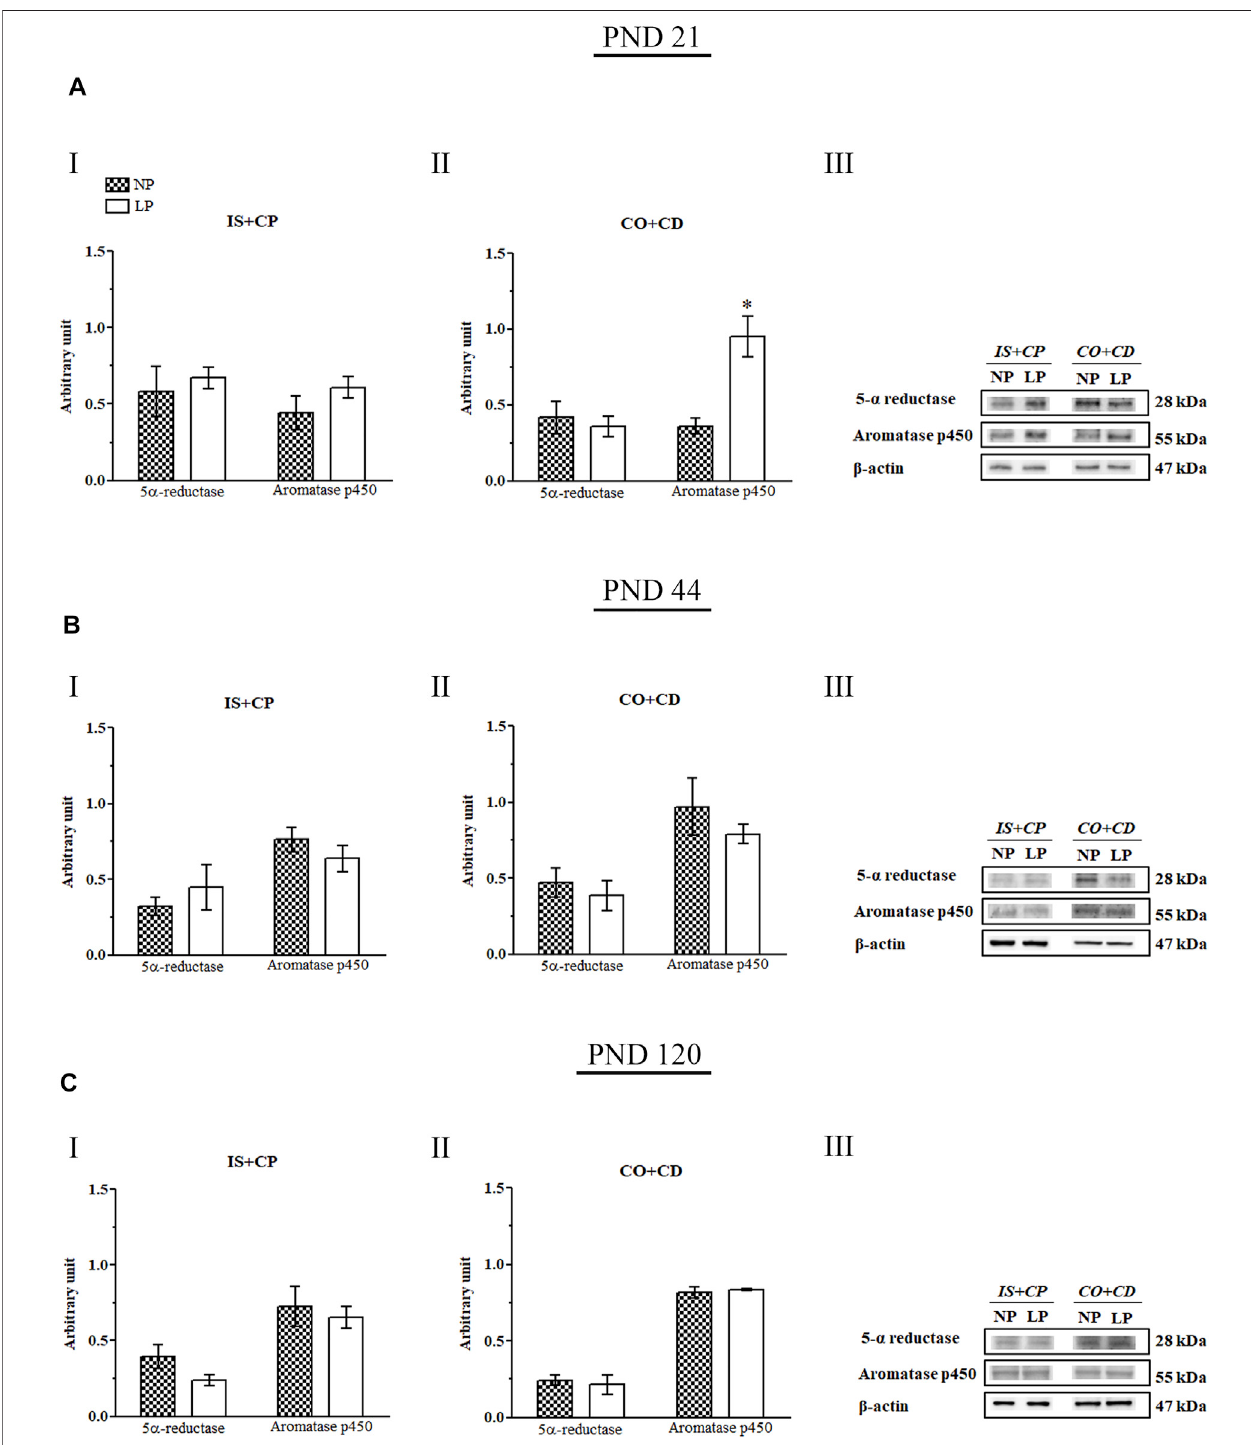
FIGURE 7 | Immunoblots of 5 α -reductase and aromatase p450. (A) Levels of 5 α -reductase and aromatase p450 in the IS + CP (I) and CO + CD (II) epididymal regionsofNPandLPanimalsonPND21.Therepresentativeblotsshowtheproteinlevelsof5 α -reductase,aromatasep450,and β -actin(70 µgofprotein)in21-day-old animals (III) . (B) Levelsof5 α -reductaseandaromatasep450intheIS+CP (I) andCO+CD (II) epididymal regionsofNPandLPanimalsonPND44.Therepresentative blots showthe protein levels of5 α -reductase, aromatasep450and β -actin (70 µg ofprotein)in 44-day-old animals (III) . (C) Levels of5 α -reductase and aromatase p450 in the IS + CP (I) and CO + CD (II) epididymal regions of NP and LP animals on PND 120. The representative blots show the protein levels of 5 α -reductase, aromatase p450 and β -actin (70 µg of protein) in 120-day-old animals (III) . The data are presented as the mean ± S.E.M. * p < 0.05, Mann-Whitney test.